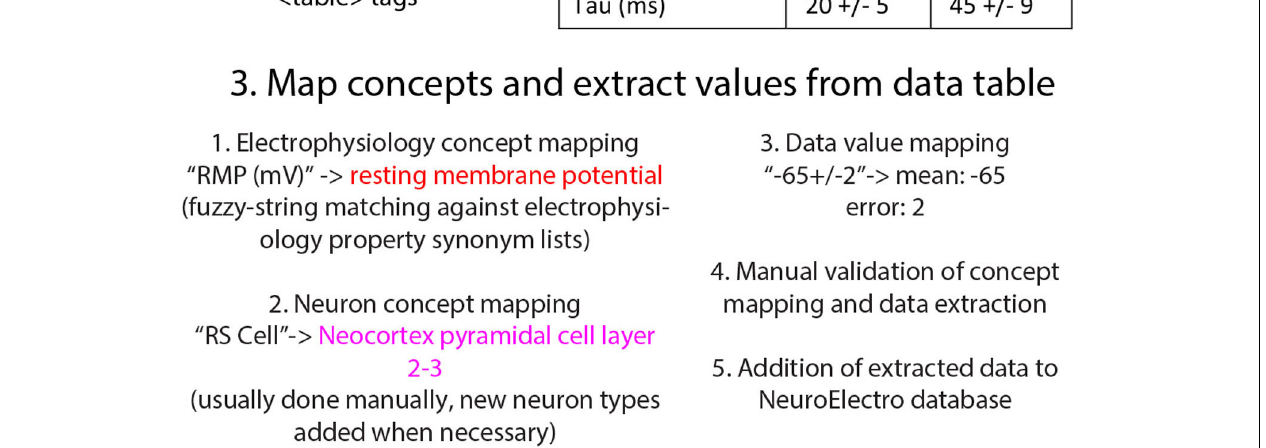
FIGURE 1 | Illustration of workflow for obtaining electrophysiological information from the research